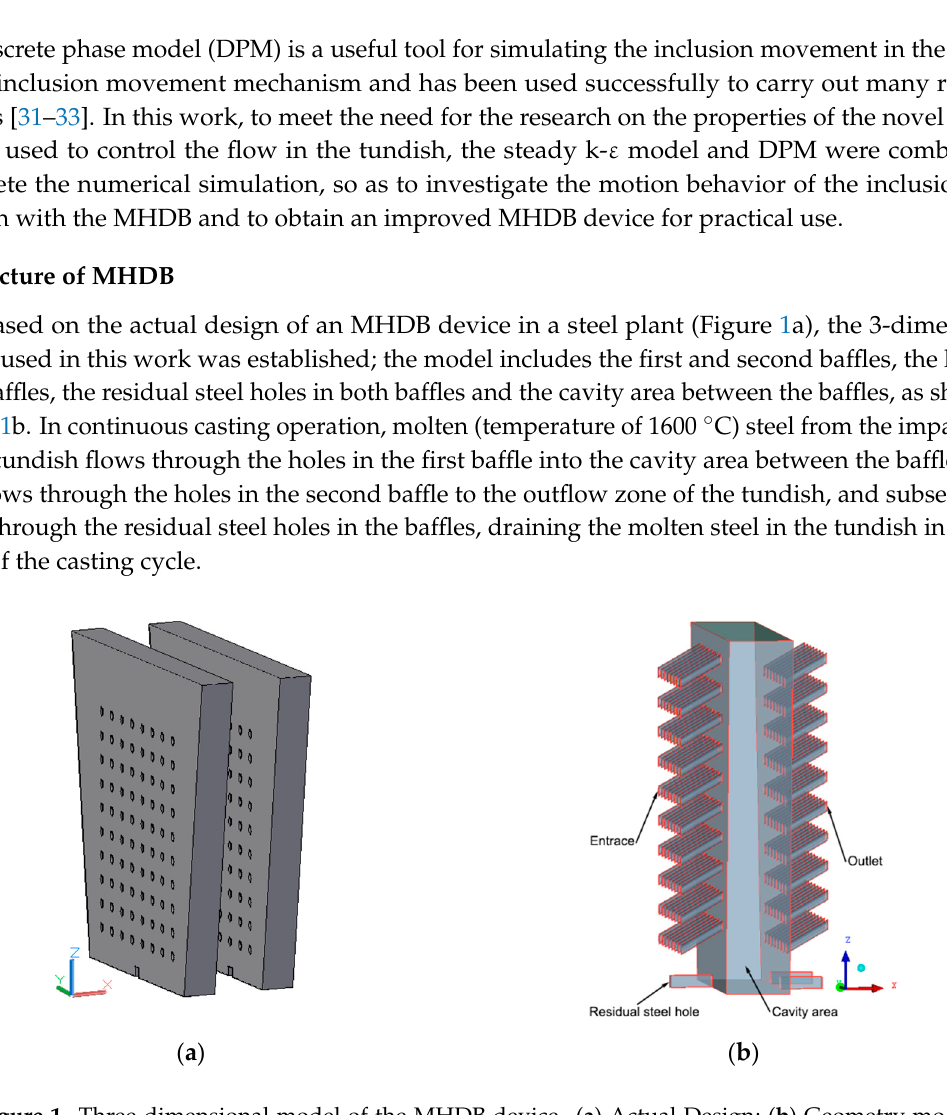
Figure 1. Three-dimensional model of the MHDB device. ( a ) Actual Design; ( b ) Geometry model in simulation.